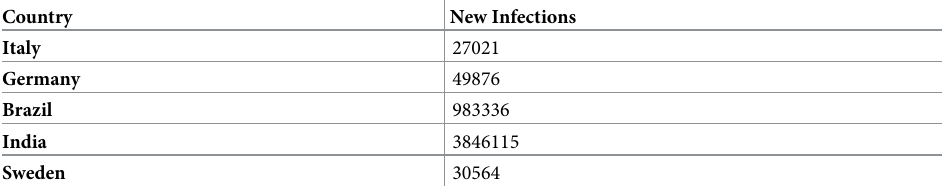
Table 3. Total number of new infections 14 days after the outbreak in Italy, Germany, Brazil, India, and Sweden, when the proportion of invisible-spreaders is 0.4%. Country